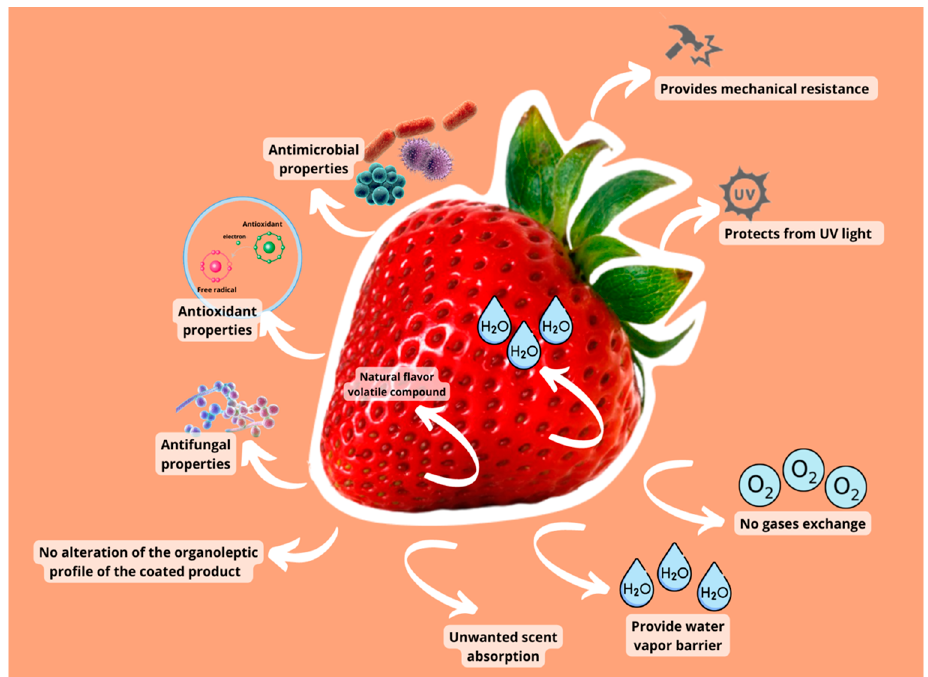
Figure 2. The direct correlations between coating qualities and the quality variables preserved in fruits and